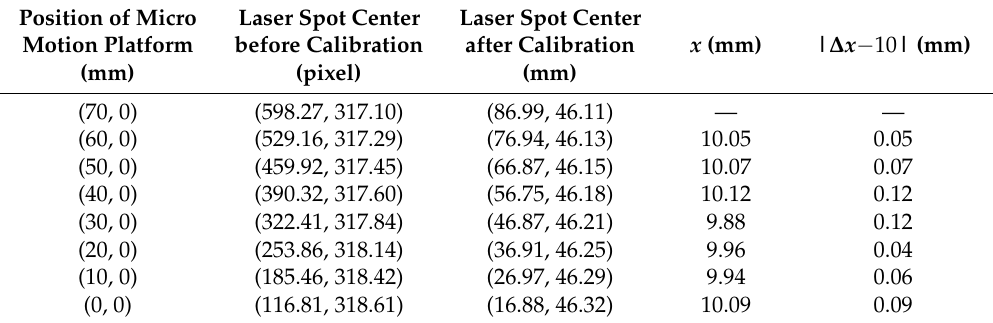
Table 3. Detection accuracy test experimental data.